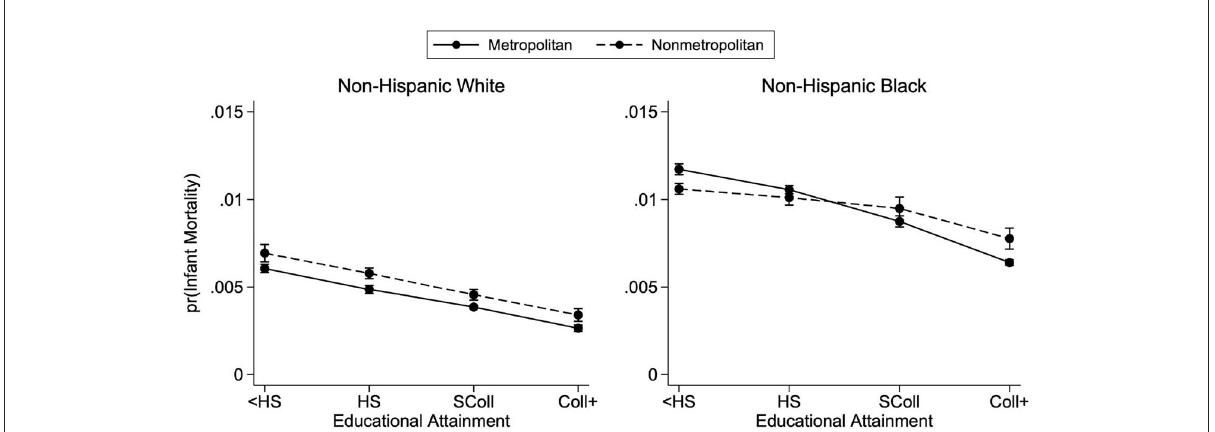
FIGURE1 Predicted probabilities of infant mortality by metropolitan residence and race, 2011–2015. Predicted probabilities are from logistic regressions controlling for mother’s age, mother’s marital status, first trimester prenatal care, child’s sex, birth order, birth year, U.S. region of birth, and mother’s county of residence’s metropolitan status. See Table 3 for full regression results. Births occurred between the years 2011 and 2015. Educational attainment is observed only from the revised birth certificates which had not yet been adopted by every